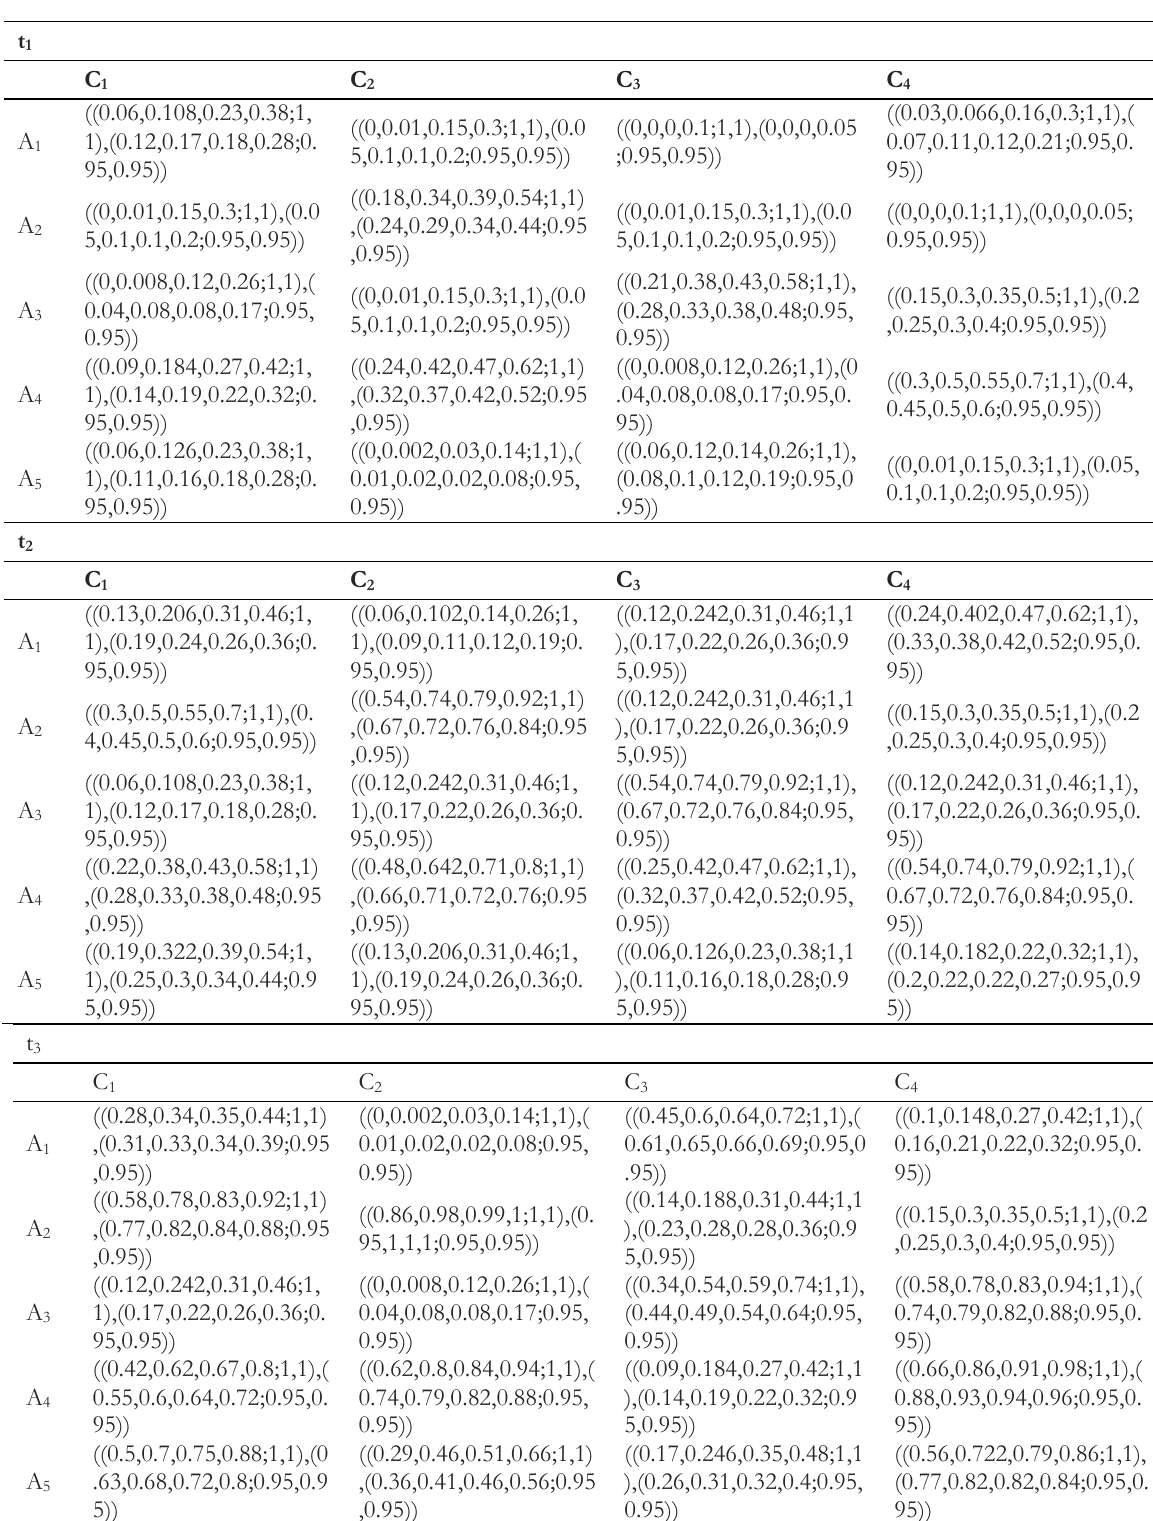
Table 3. Weighted average of the attributes evaluated by decision-makers in three periods of